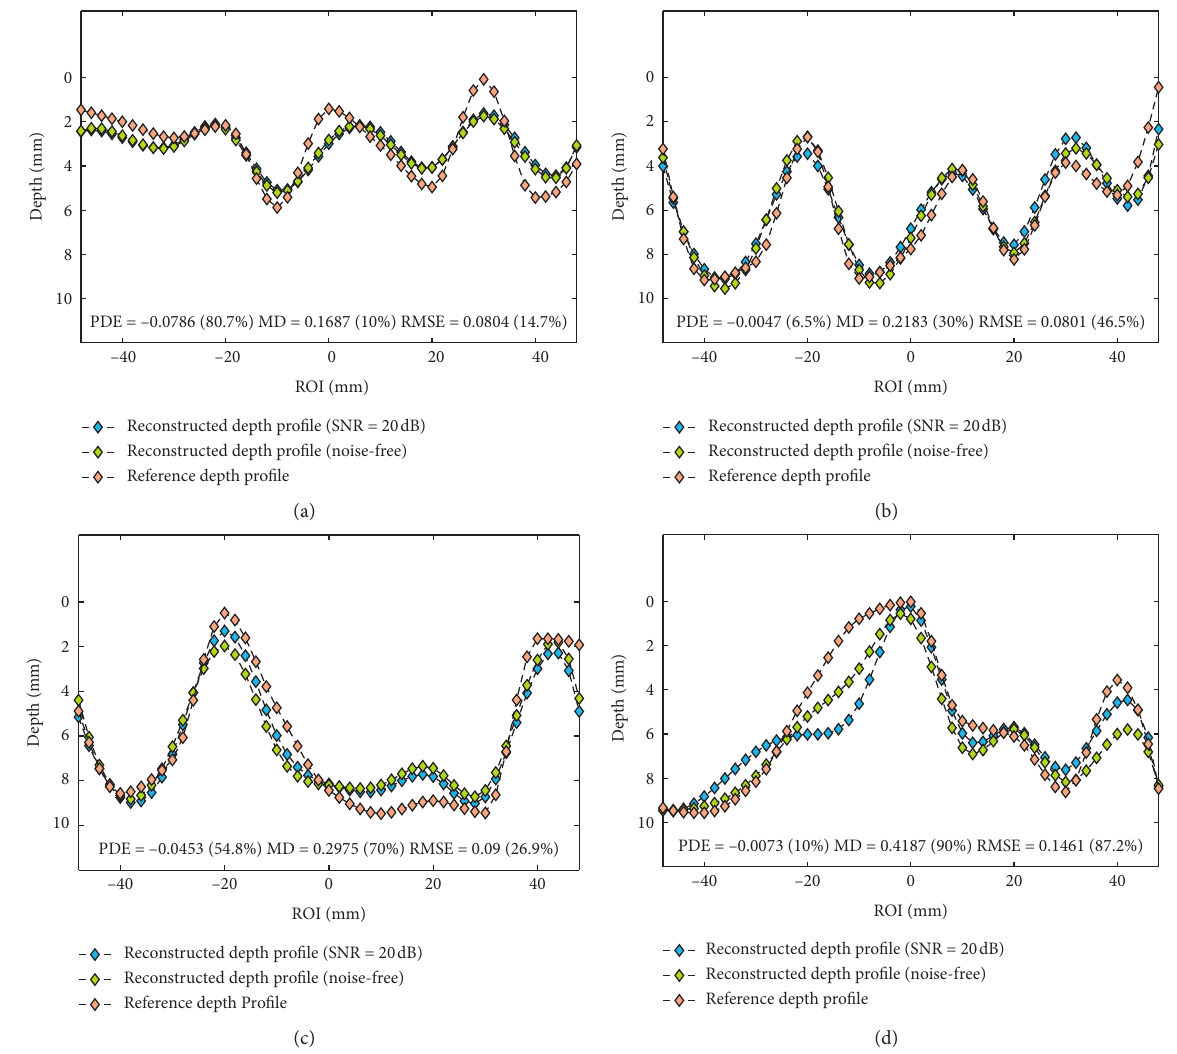
Figure 10: Sizing results with different ranking of MD value. (a) 10% ranking. (b) 30% ranking. (c) 70% ranking. (d) 90% ranking.